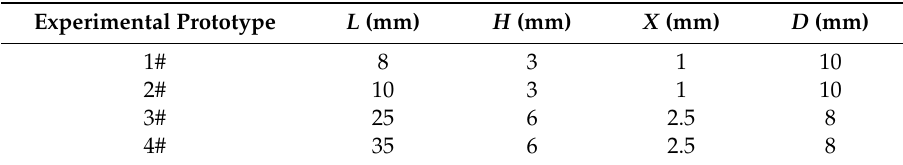
Table 1. Structural parameters of the experimental prototype.